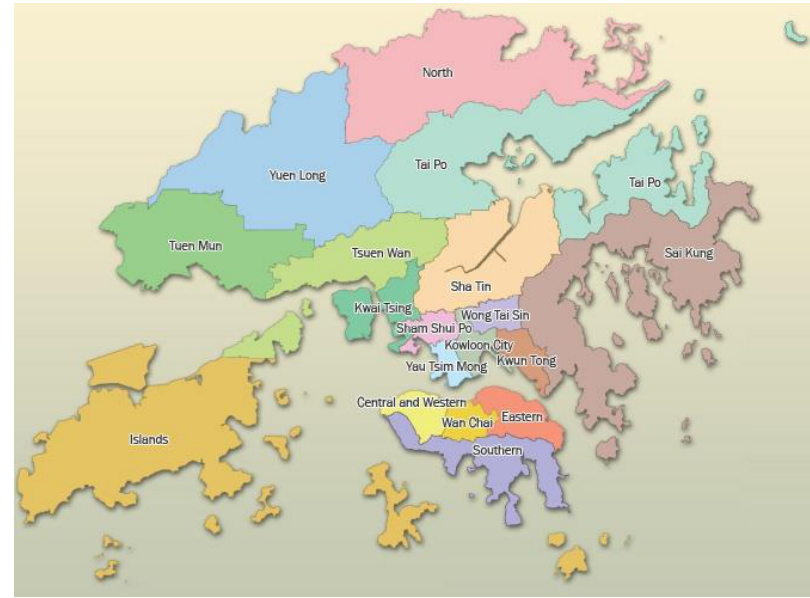
Figure 1. Map of Hong Kong (Source: [19]). Table 1. Profile of the selected districts.